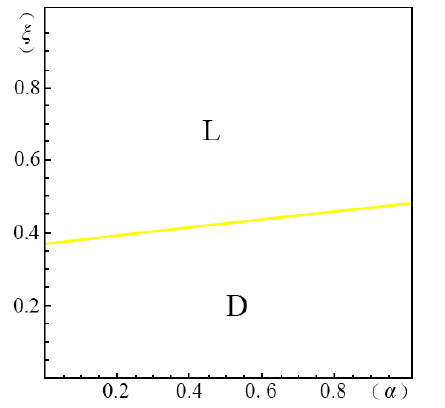
Figure 1. Comparison of the four strategies given (cid:2012) (cid:3404) (cid:2869)